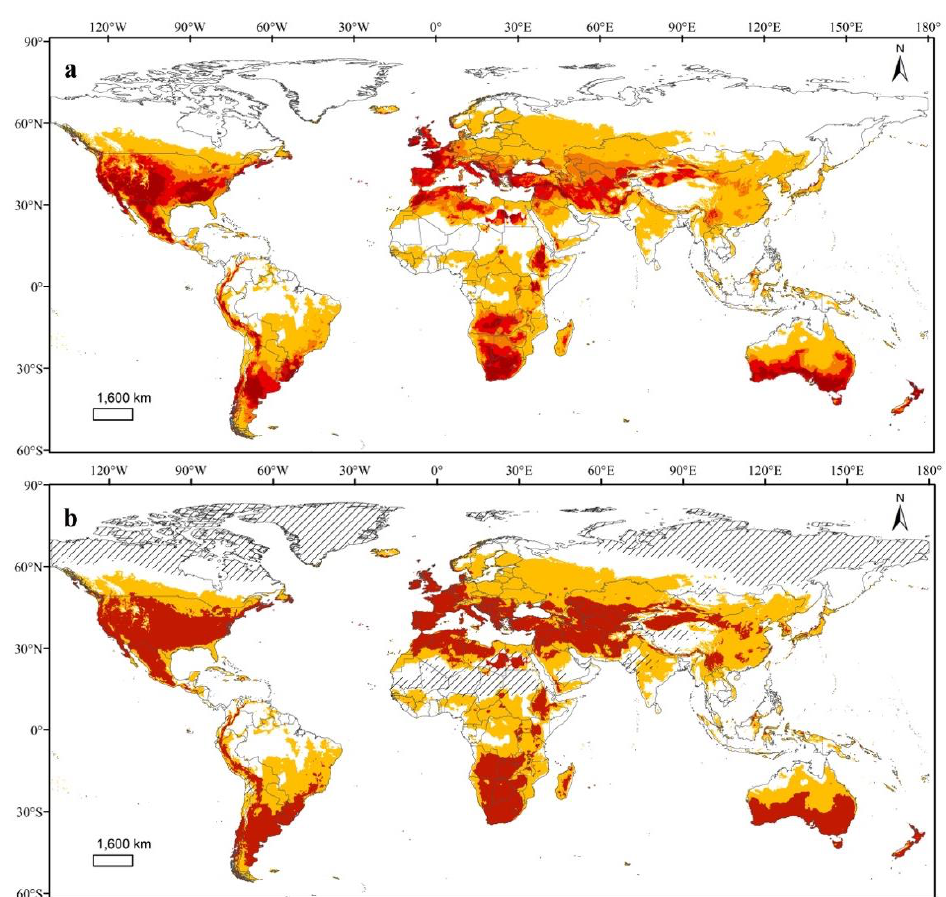
Figure 4. Predicted suitable habitats for tomato potato psyllid (TPP) and the associated plant pathogen Candidatus Liberibacter solanacearum (CLso) shown as logistic ( a ) and binary ( b ) output. In the logistic map, dark red colors represent higher suitability. Orange and red colors in the binary map represent suitable and optimal conditions for TPP and CLso, defined by the minimum training presence threshold (MTP) and 10% training presence threshold (TP10), respectively. The black simple hatch lines in the binary map indicate the non-analogous environments between the model’s calibration and projection areas identified by MESS analysis .